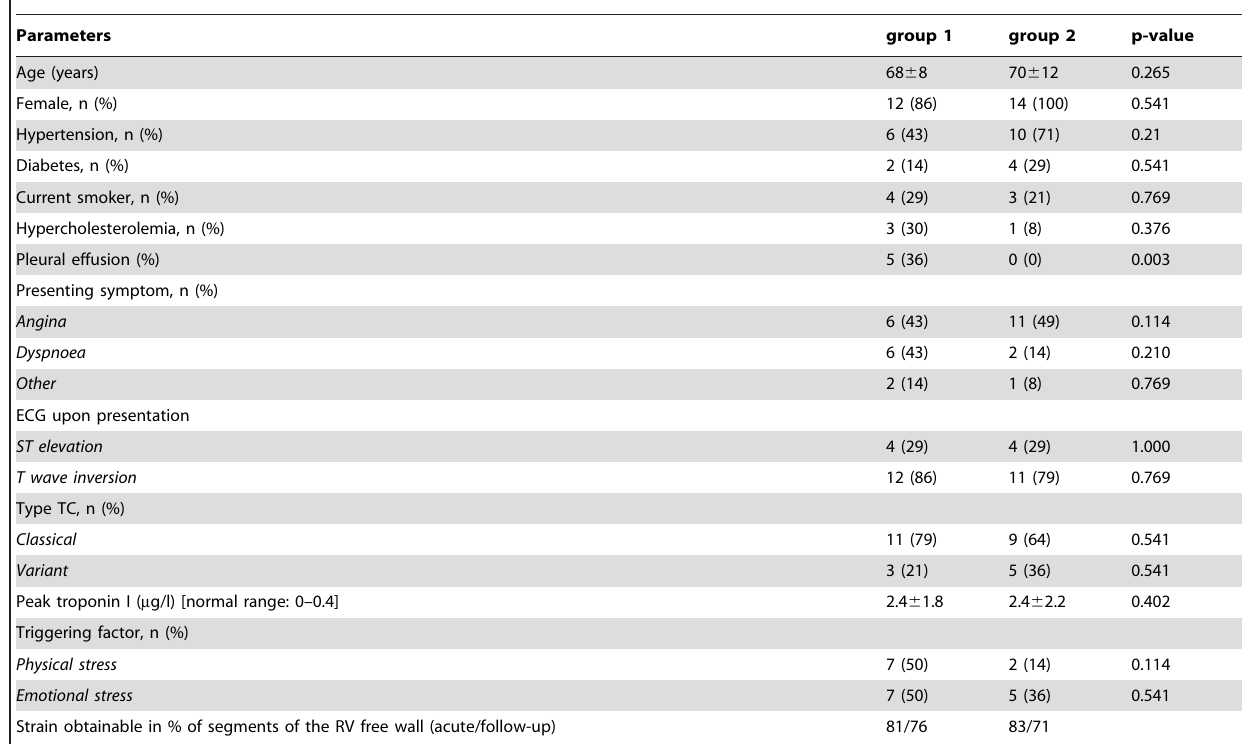
Table 1. Baseline clinical and echocardiographic characteristics for patients with TC with biventricular involvement (group 1) and only left ventricular involvement (group